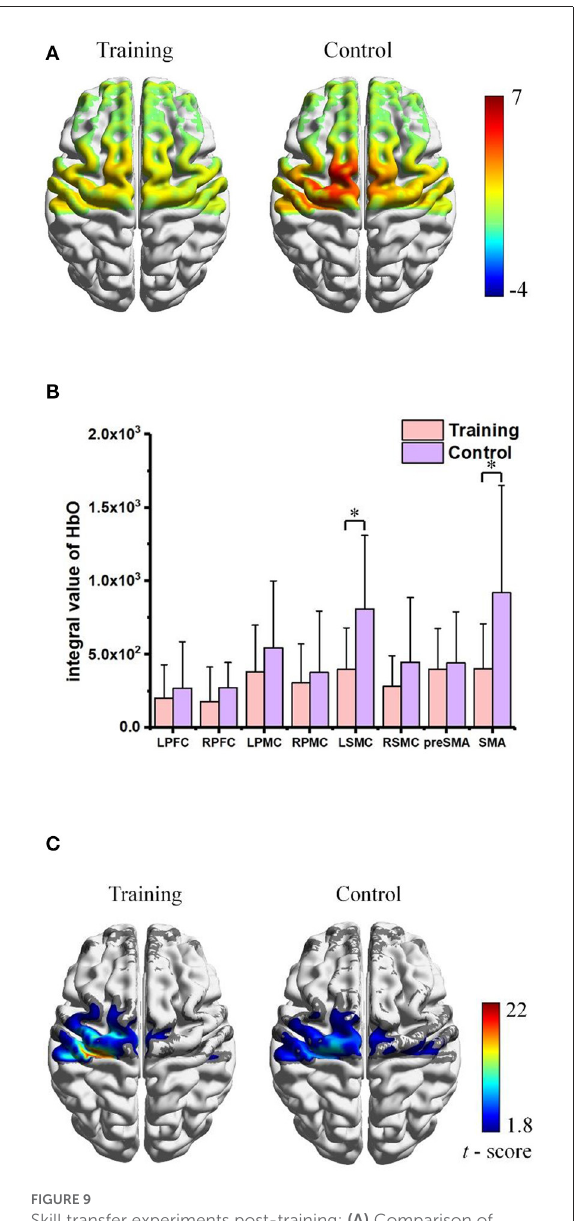
FIGURE9 Skill transfer experiments post-training: (A) Comparison of cortical hemodynamic activation maps. (B) Averaged Integral Value of 1 [HbO] activation within ROIs. Significant level: * as p < 0.05. (C) Corresponding FC pattern maps, with only statistically significant FC strength are shown ( p <